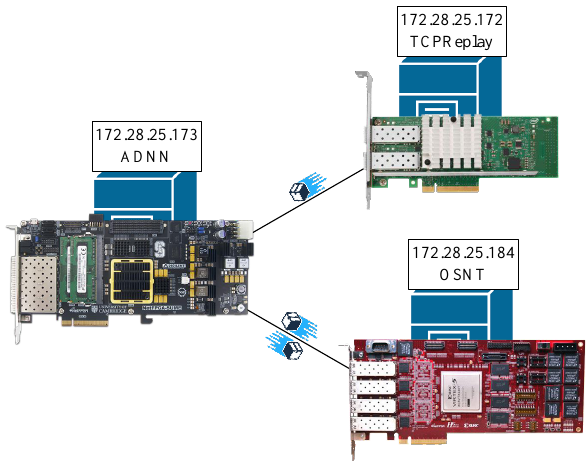
Figure 10. The testbed system for evaluate the proposed ADNIS. The tested system includes three main components as